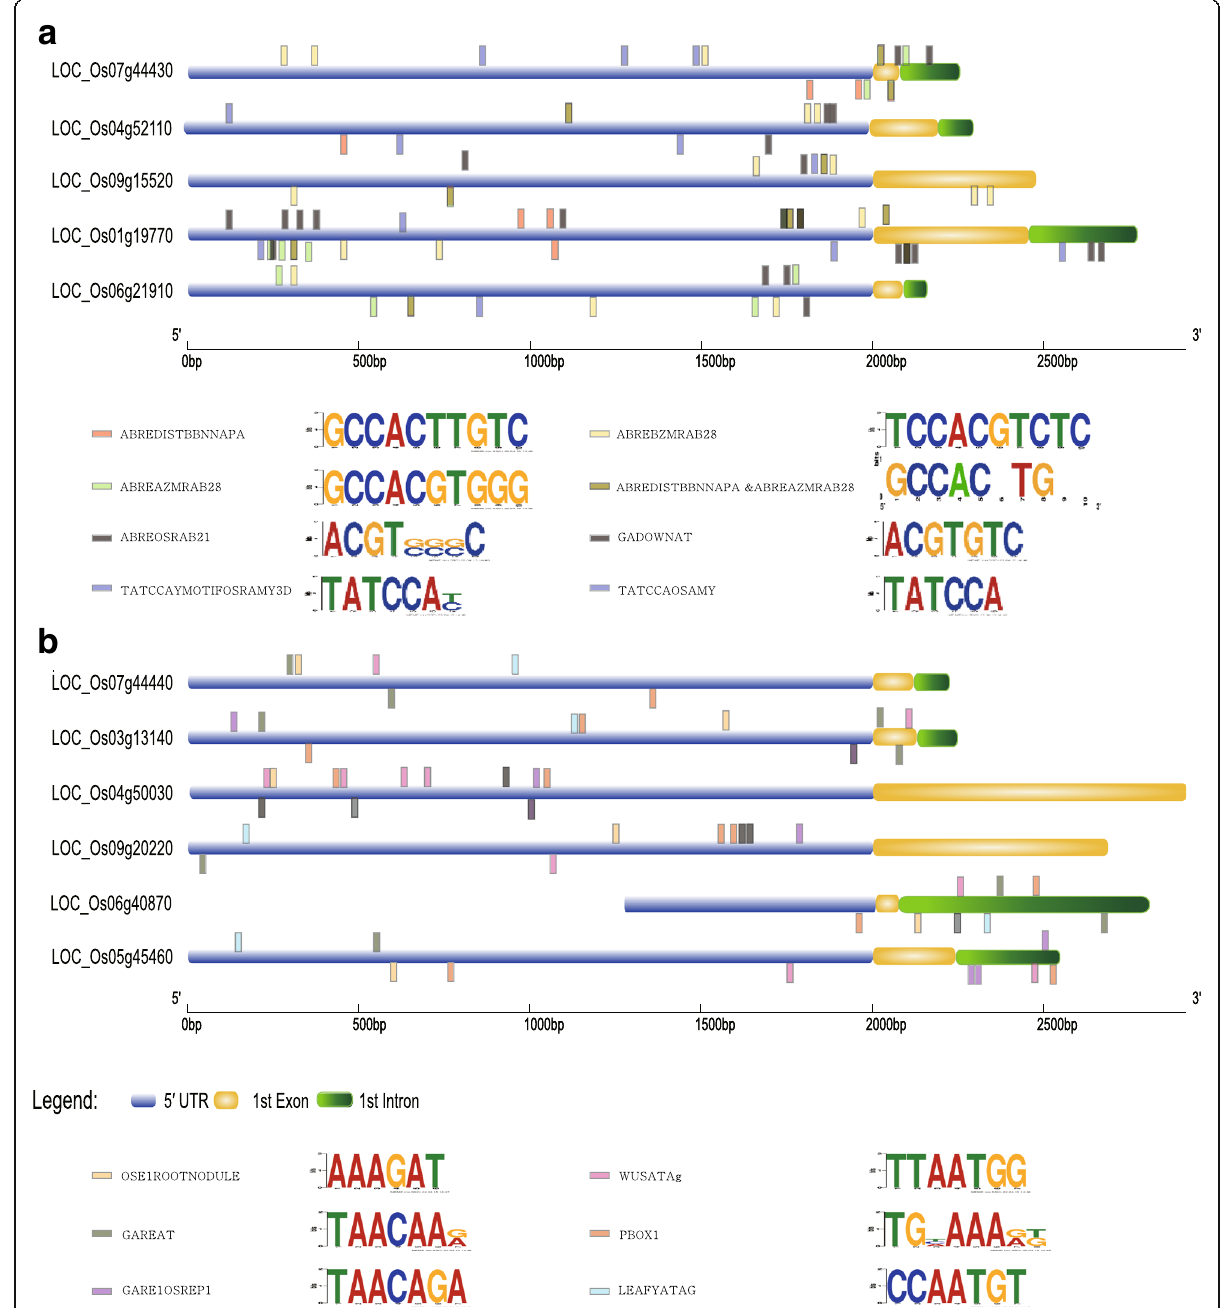
Fig. 4 Identification of CREs responsible for unique expression patterns of two tandemly duplicated rice PRX genes. Mapping, names, and logos a of seven CREs to promoters of LOC_Os07g44430 and its co-expressed genes. Mapping, names, and logos b of six CREs to promoters of LOC_Os07g44440 and its co-expressed